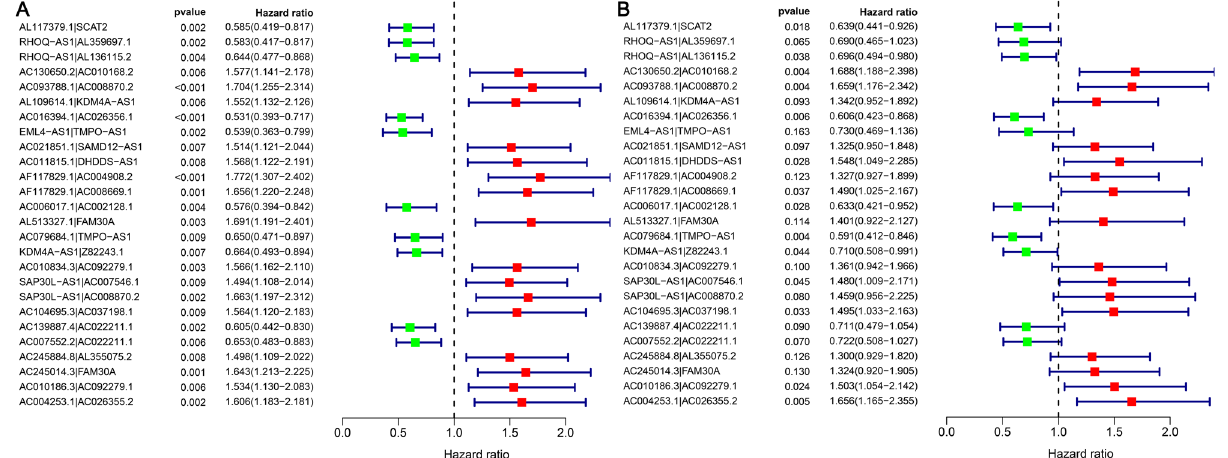
Figure 3. Results obtained from Cox regression analysis based on 26 necroptosis-related lncRNA pairs associated with the outcome of LUAD. ( A ) Forest plot of the 26 necroptosis-related lncRNA pairs associated with the outcome of LUAD by performing Cox univariate regression analysis. ( B ) Forest plot of Cox multivariate regression analysis of 26 necroptosis-related lncRNA pairs associated with LUAD. Risk factors are highlighted in red, while protective factors are highlighted in